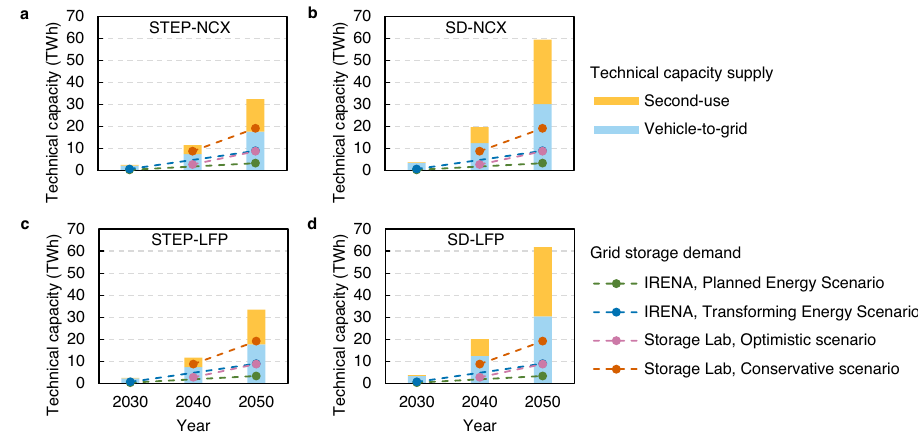
Fig. 2 | Total technical capacity for EV batteries and comparison to grid storage demand. a STEP-NCX scenario. b SD-NCX scenario. c STEP-LFP scenario. d SD-LFP scenario (see details in Supplementary Table 1). IRENA=International Renewable Energy